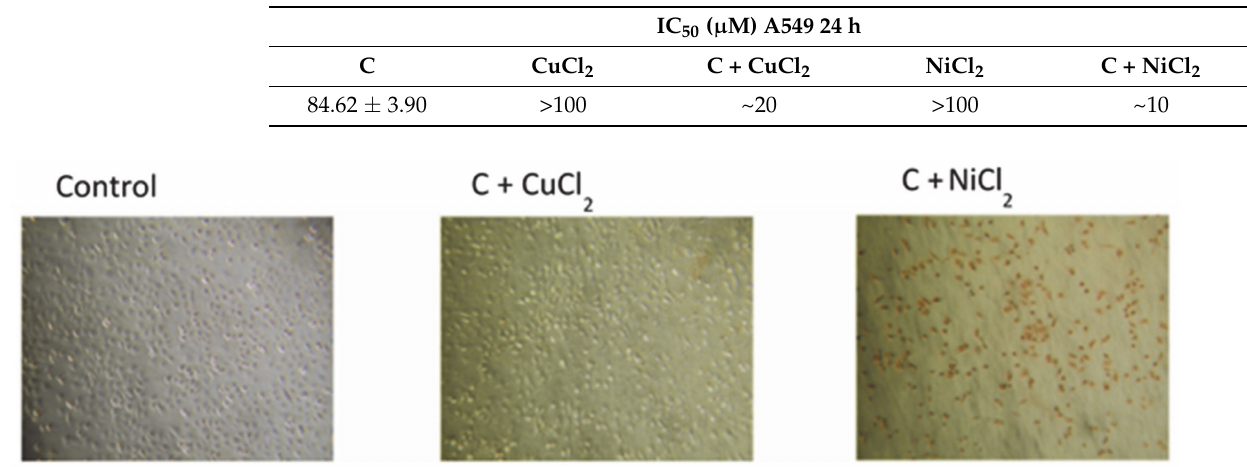
Table 2. IC 50 values determined for A549 cells treated with C mixed with copper(II) and nickel(II) chlorides.